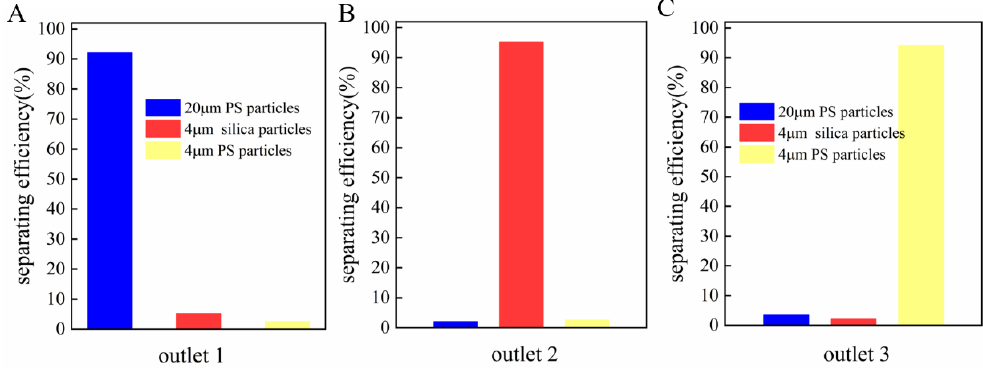
Figure 10. ( A – C ) Continuous separation of three kinds of particles in the middle channel.